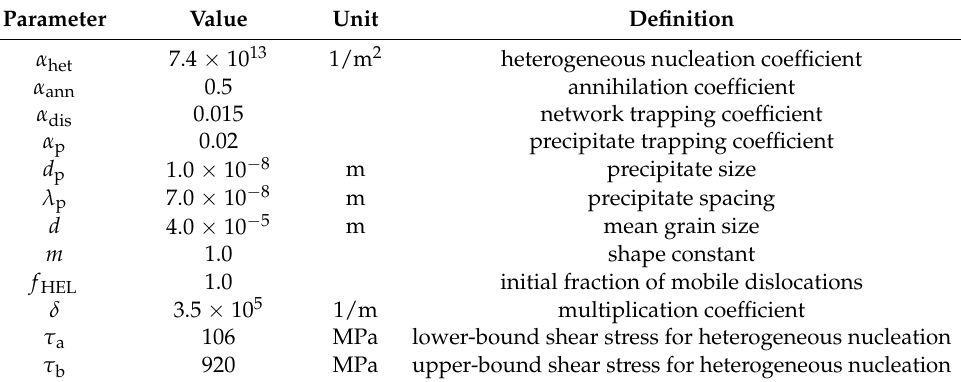
Table 3. Parameters in Equations (64)–(70) and their values for 6061-T6 Al alloy at ambient conditions